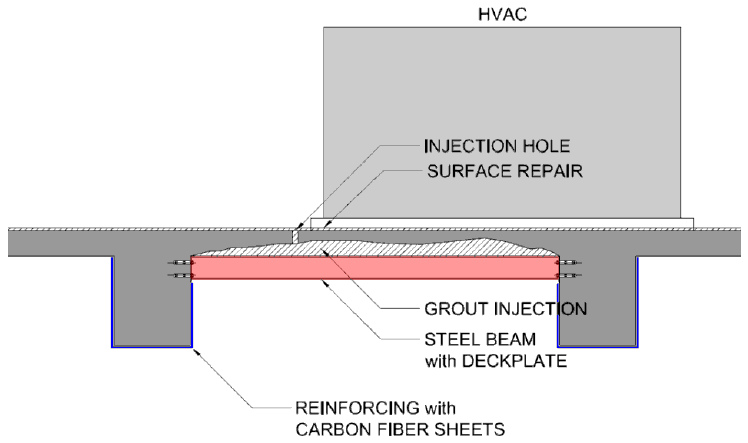
Figure 18. Alternative rehabilitation plan with HVAC remaining in position during rehabilitation work.